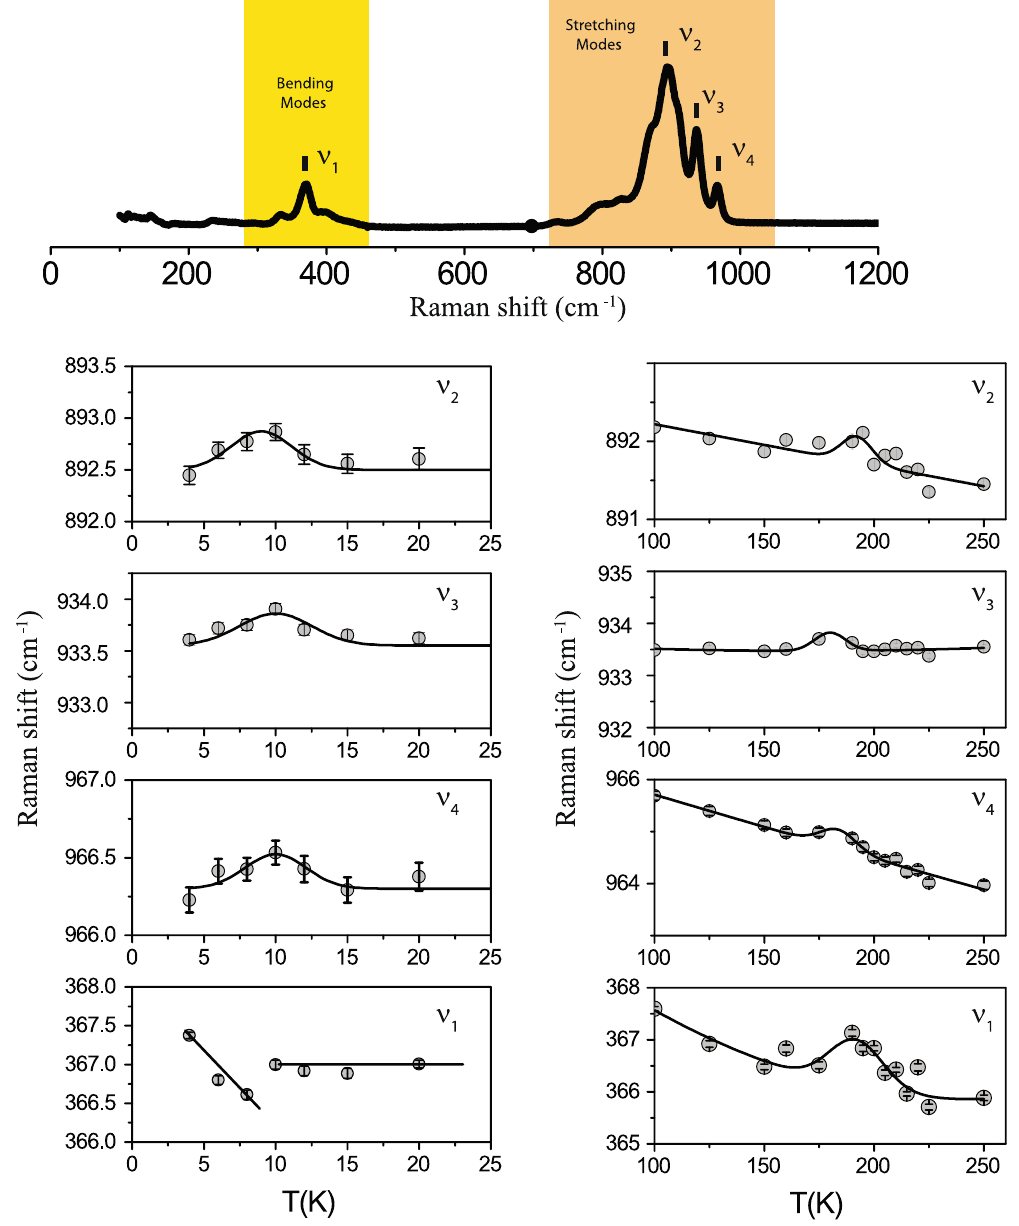
Figure 7. The room temperature Raman spectrum of Li Ni Mo O incident laser beam of wavelength 488 nm is shown in the top panel. The bottom left and right panels show the variation of the spectral features corresponding to ν 250 K. The solid lines are guides to the